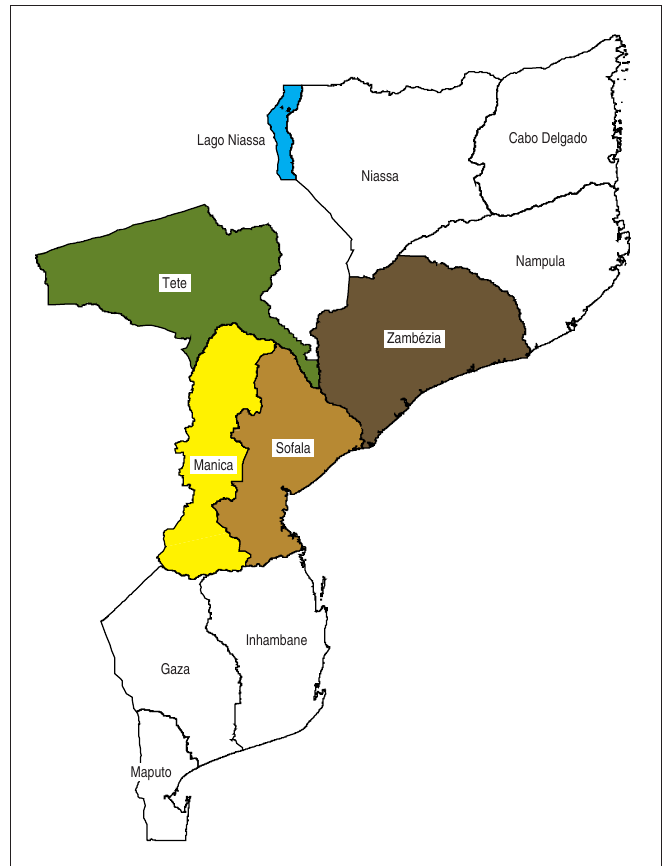
FIG. 1 Map of Mozambique showing the four provinces of the